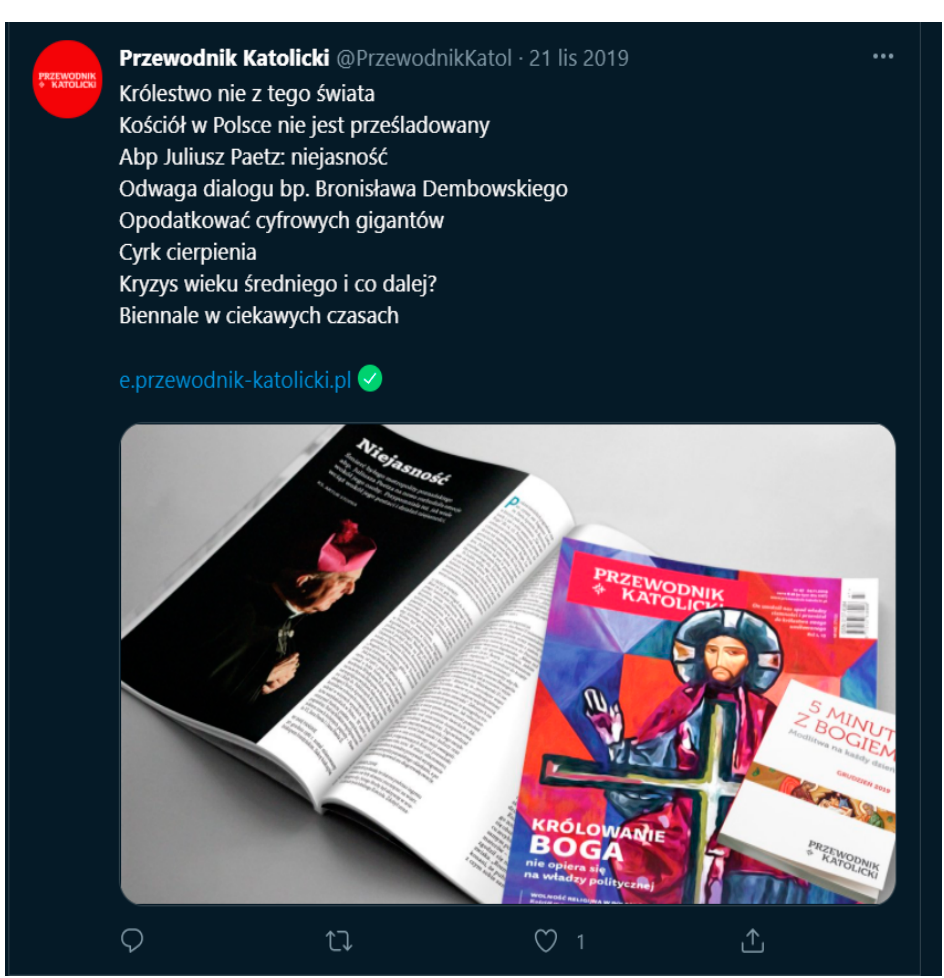
Figure 3. A promotional tweet by Przewodnik Katolicki , 21.11.2019. Source: Twitter/screenshot.